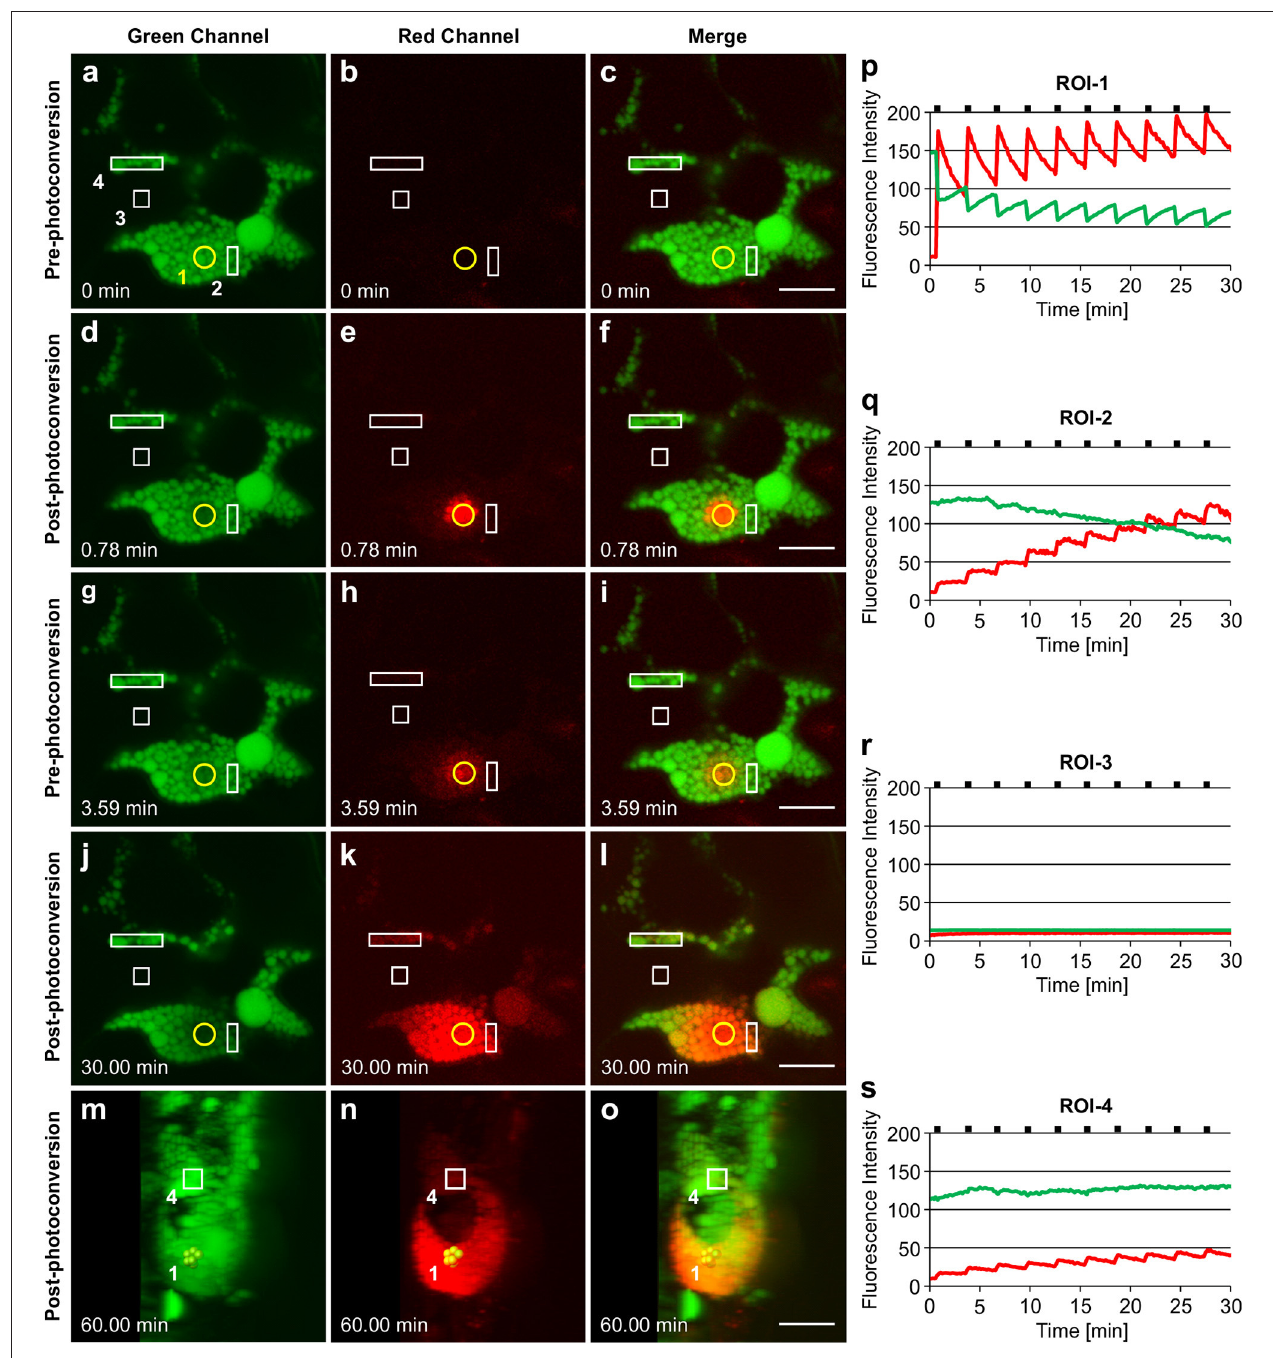
FIGURE 5 | Trafficking of proteins between GFP-HFBI-induced protein bodies. (A–C) GFP-HFBI-induced PBs form clusters and can only be visualized in the green channel before photoconversion. The yellow circle represents the region of irradiation (ROI-1). Regions of interest (ROI 2-4) are shown in white rectangles. (D–F) Upon irradiation of ROI-1, GFP in PBs within the circle photoconverts to red and starts spreading into neighboring PBs. (G–I) Within ∼ 3 min of the first irradiation, GFP recovers at ROI-1 and the red signal is spread to neighboring and distant PBs more than 10 µ m away from ROI-1. (J–L) After multiple irradiations (using 3 min time intervals) of ROI-1, sufficient red fluorescence is produced that shows the trafficking of the photoconverted protein from ROI-1 to ROI-4 and PBs further away (more than 20 µ m from ROI-1). (M–O) 3D representation of the PB cluster at a 90 ◦ rotation. PBs irradiated at ROI-1 are highlighted in yellow. ROI-4 is shown with a square. PBs between ROI-1 and ROI-4 are linked with a chain of PBs at a different focal plane within the cell. (P–S) Changes in fluorescence intensity of the green and red signal in ROI-1 (P) , ROI-2 (Q) , ROI-3 (R) , and ROI-4 (S) . Black notches indicate the time of irradiation. All images were acquired at 4-dpi in sequential mode. Bar, 10 µ